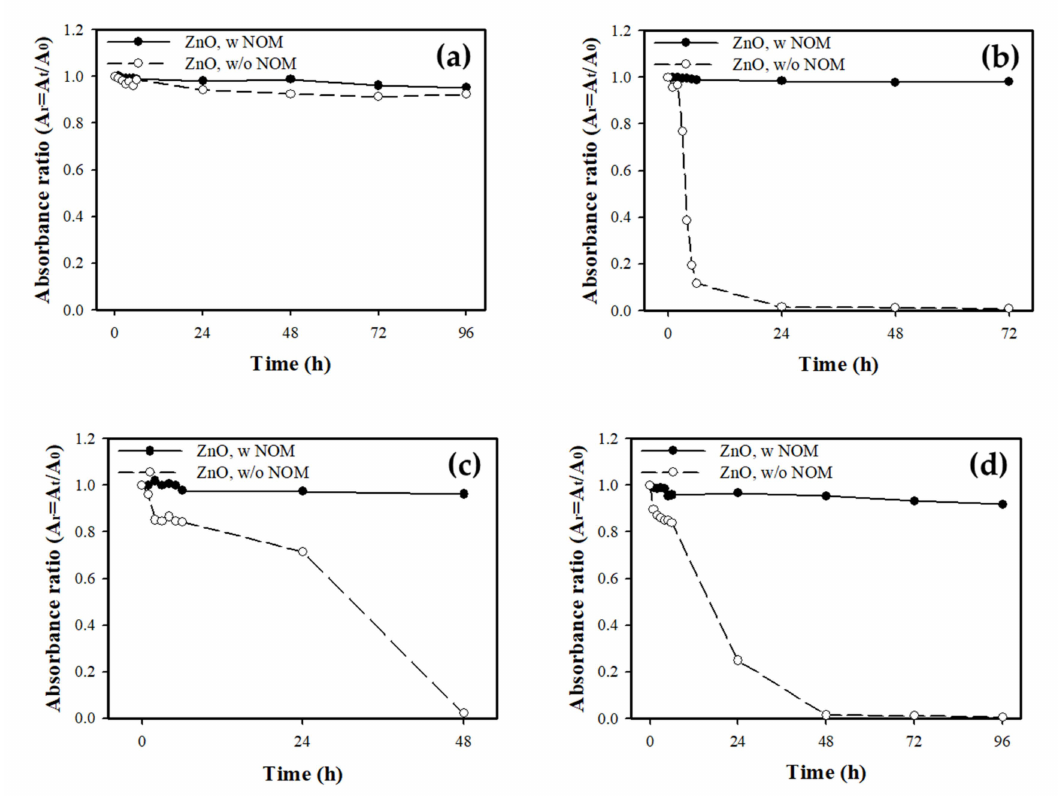
Figure 1. Sedimentation kinetics for zinc oxide nanoparticles (ZnO NPs) with / without natural organic matter (NOM) under deionized water (DI) water ( a ), Organization for Economic Co-operation and Development (OECD) medium ( b ), International Organization for Standardization (ISO) medium ( c ), and dechlorinated tap water ( d